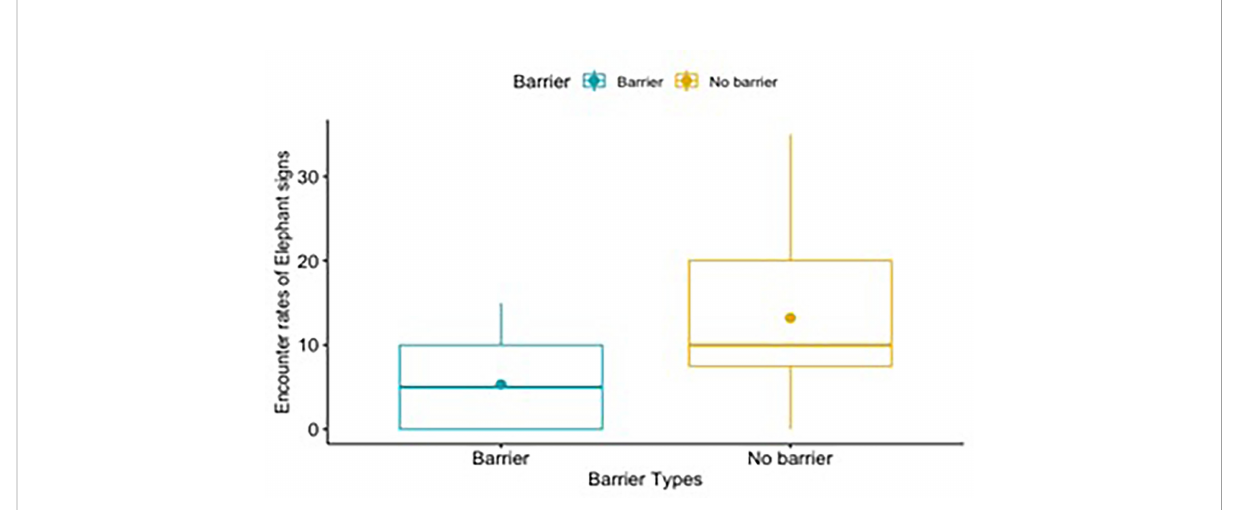
FIGURE 7 Box plot indicating quantiles and mean encounter rates of barrier and non-barrier